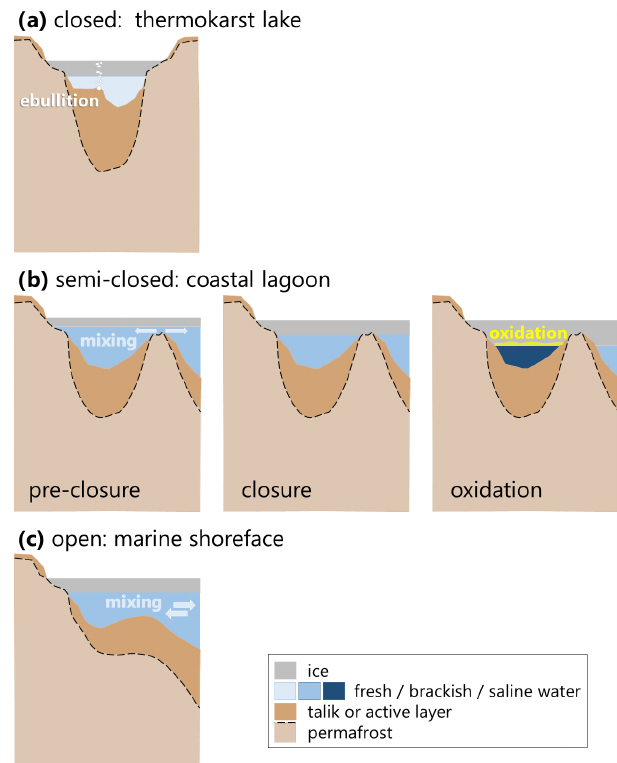
Figure 7. Schematics of geomorphological differences between the three aquatic systems under investigation: (a) the closed system rep- resents a typical thermokarst lake, such as LK, with a closed talik and a complete winter ice cover over fresh water; (b) the semi- closed system is a brackish to highly saline water body (LG), whose ice cover separates it from the marine system at some point during the winter and for which continued ice growth can lead to hyper- salinity; and (c) the open system (BY), where ice cover growth does not prevent mixing with marine and/or fluvial waters beneath the